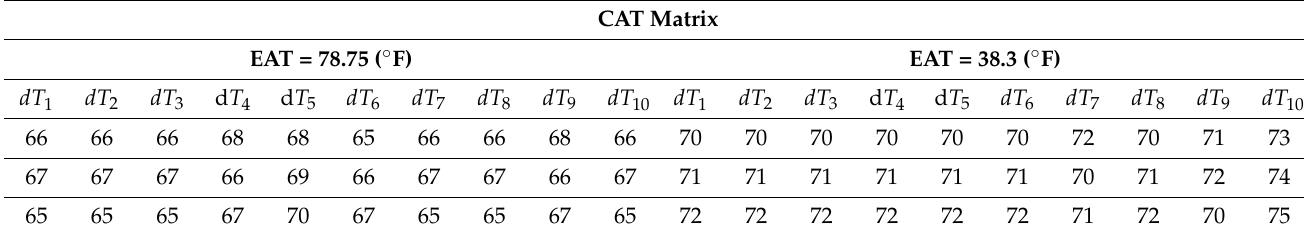
Table 5. ACCSSP = 70 MPH: Optimal CAT Matrix—(100 steps = 1